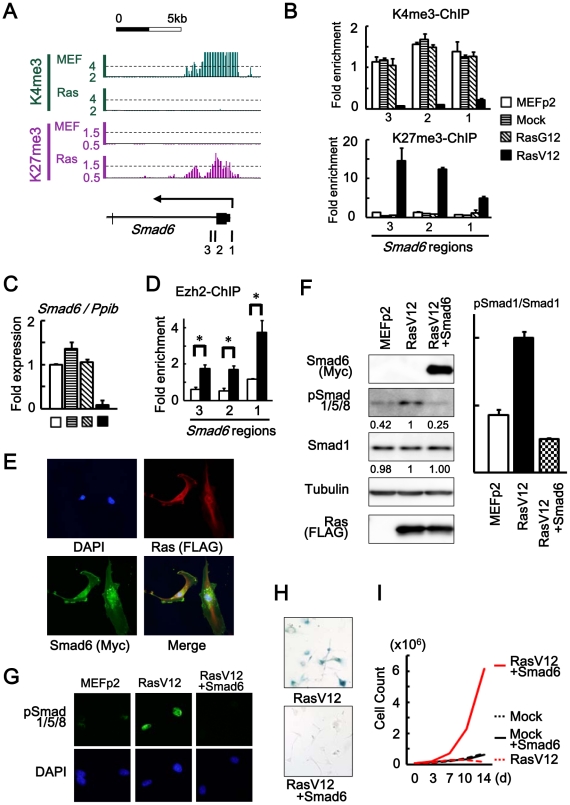

Smad6 repression in senescence.(A) Loss of H3K4me3 and gain of H3K27me3 around TSS of Smad6, shown by ChIP-sequencing. 1, 2, 3; regions for ChIP-PCR. (B) Real-time ChIP-PCR showing H3K4me3 loss and H3K27me3 gain specifically in RasV12 cells. There was no alteration in Mock cells and RasG12 cells, thus no alteration during passages. (C) Real-time RT-PCR analysis of Smad6, showing repression to 0.05-fold specifically in RasV12 cells. There was no repression in Mock cells and RasG12 cells, thus no alteration during passages. (D) Real-time ChIP-PCR for Ezh2 showing increased enrichment of Ezh2 around Smad6 TSS in RasV12 (*P<0.05). (E) Cellular immunofuorescence for RasV12 and Smad6. RasV12 with N-terminal FLAG and Smad6 with N-terminal Myc were detected using anti-FLAG and anti-Myc antibodies. Simultaneous expression of RasV12 and Smad6 proteins in Smad6-introduced RasV12 cells was confirmed (See also Figure S7). (F) Western blot analysis showing increased level of Smad1/5/8 phosphorylation in RasV12, and decrease in Smad6-introduced RasV12 cells. Numbers under bands of phosphorylated Smad1/5/8 and pan-Smad1 showed densities relative to the band for RasV12 cells (left panel), and the ratio of densities for phosphorylated Smad1/5/8 to pan-Smad1 was decreased to 0.25-fold in Smad6-introduced RasV12 cells (right panel). (G) Cellular immunofuorescence of phosphorylated Smad1/5/8. Nuclear accumulation of phosphorylated Smad1/5/8 was detected in RasV12 cells, but not in Smad6-introduced RasV12 cells. (H) SA-β-gal staining. The number of SA-β-gal(+) cells were significantly decreased in Smad6-introduced RasV12 cells compared with RasV12 (See also Figure S8). (I) Growth curve. Smad6-introduced RasV12 cells showed continual growth faster than Mock cells or Smad6-introduced mock cells.